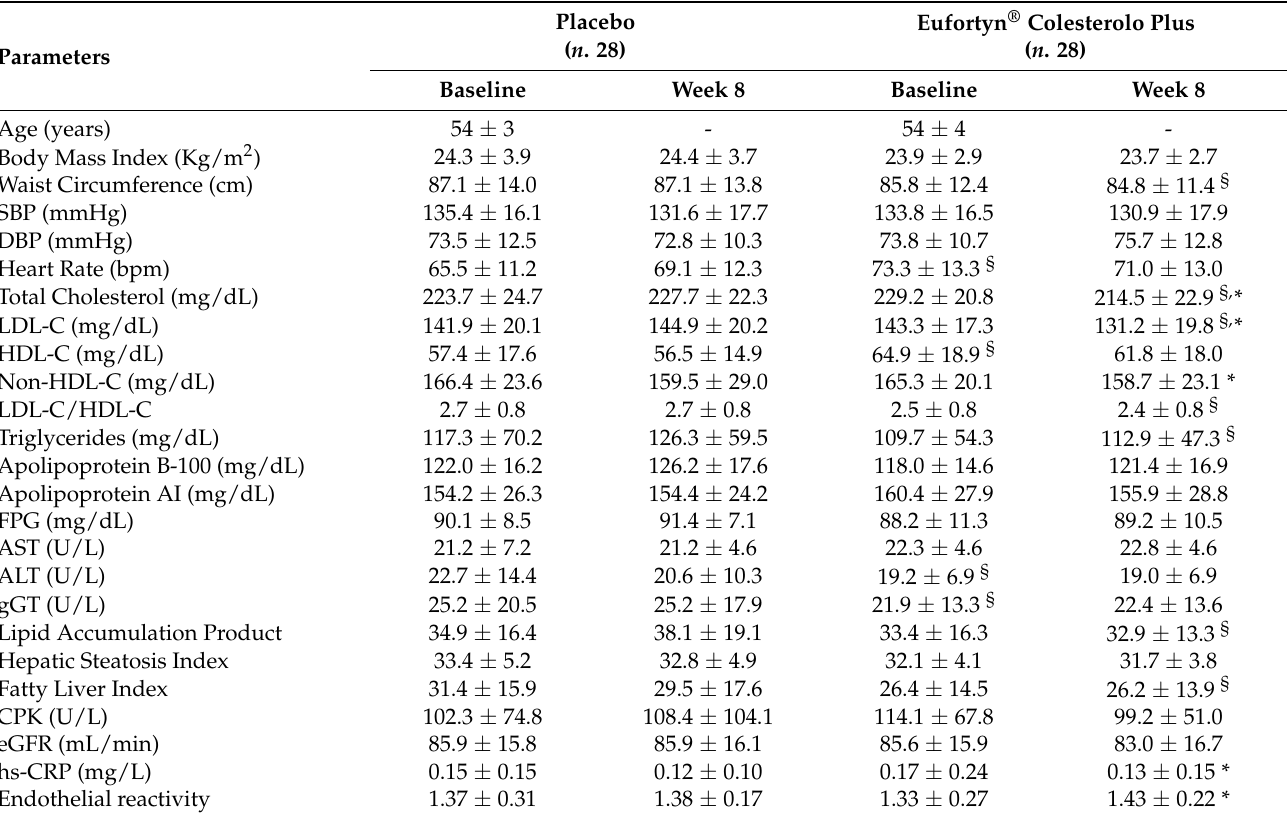
Table 3. Anthropometric, hemodynamic and blood chemistry parameters from the baseline to the end of the clinical trial, expressed as mean ±